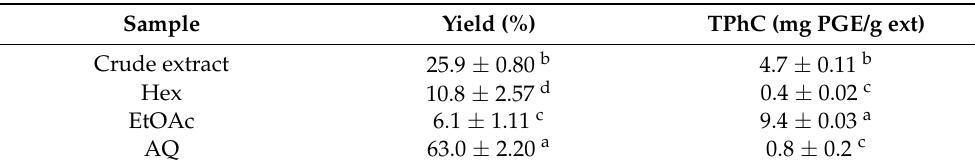
Table 2. Extraction mass yield and total phlorotannin content (TPhC) of S. vulgare crude extract and purified